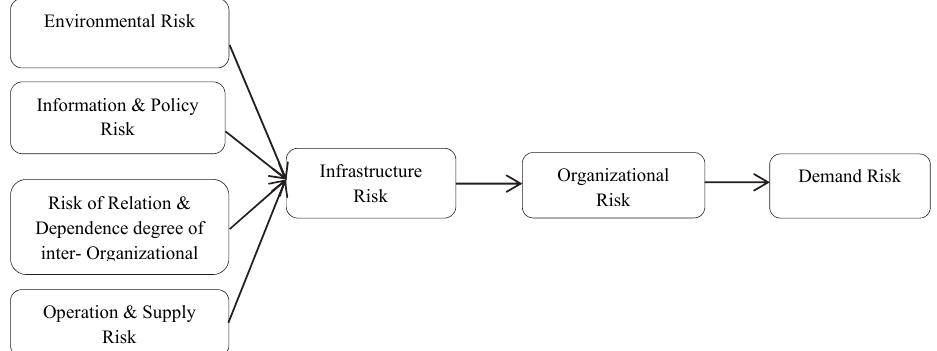
Fig. 1. Conceptual Model for Risk in E-Supply